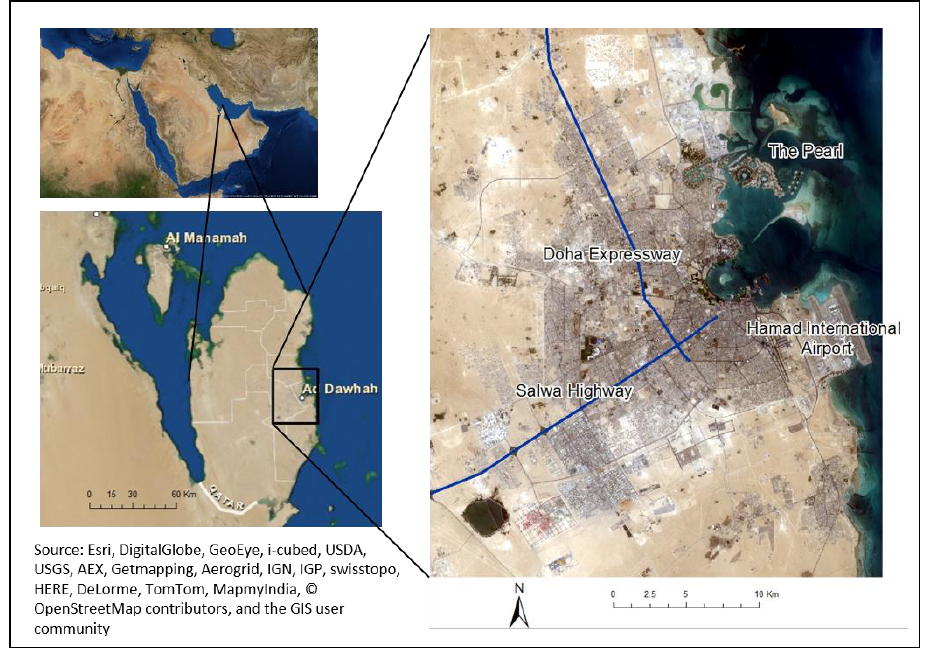
Figure 1. Doha study area.